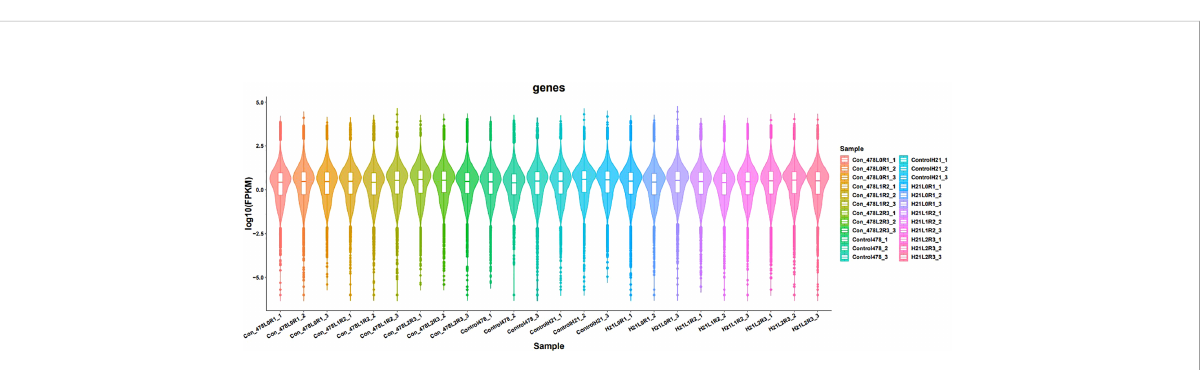
FIGURE 11 Results of different samples showing gene expression in the form of violin; the violin having different colors, indicating different samples analyzed at regular